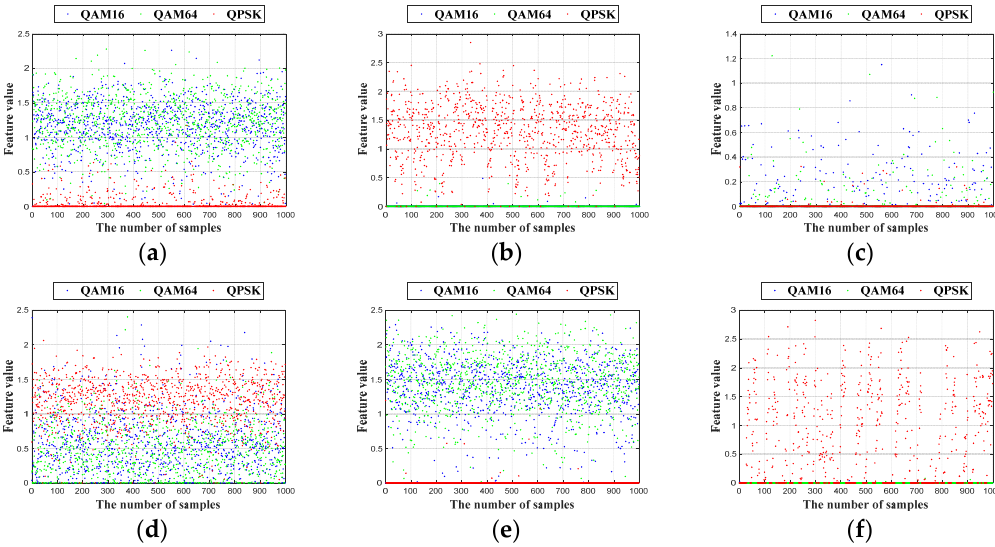
Figure 11. Visualization of typical feature outputs of the dense layer. ( a ) The 5 th feature, ( b ) the 11 th feature, ( c ) the 39 th feature, ( d ) the 58 th feature, ( e ) the 63 rd feature, and ( f ) the 98 th feature.